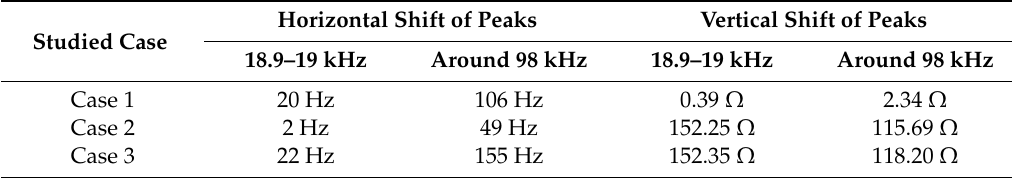
Figure 7. Horizontal and vertical shifts of the impedances (real part) pipe-1/PZT-1: ( a ) at low frequency and ( b ) at high frequency. Table 3. Horizontal and vertical shifts of the real part of the impedance between the signatures at − 40 ◦ C and + 80 ◦